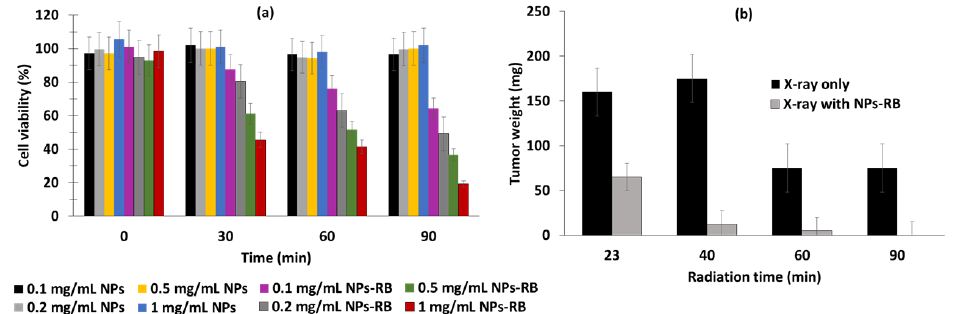
Figure 44. Antitumor effect of NPs and NPs-RB on nude mice bearing HepG2 tumor cells subcutaneously. NPs or NPs-RB were injected intratumorally. ( a ) HepG2 cell viability after 90 min irradiation, 1.5 Gy, 24 h incubation. ( b ) Tumor weight with different irradiation times. Dissected tumor tissues were obtained from nude mice incubated for 24 h with 10 mg/mL NPs-RB. The X-ray tube was set at 80 kV, 0.5 mA and 1.17 Gy/h. Adapted from Zhang et al. [111]. Zhang et al. [112] designed X-ray-luminescent NPs (XLNPs-RB). The XLNPs-RB were composed of a β NaLuF 4 :Tb 3+ core with ultra-high FRET efficiency and RB covalently coupled to the core. The NPs were functionalized with AEP (2-aminoethyl dihydrogen phosphate) to increase water dispersity (Figure